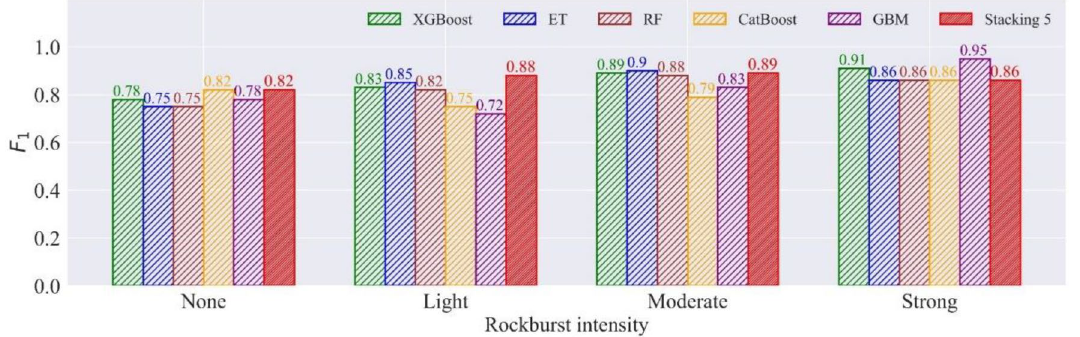
Figure 15. The comparison of F 1 in stacking 5 and its base